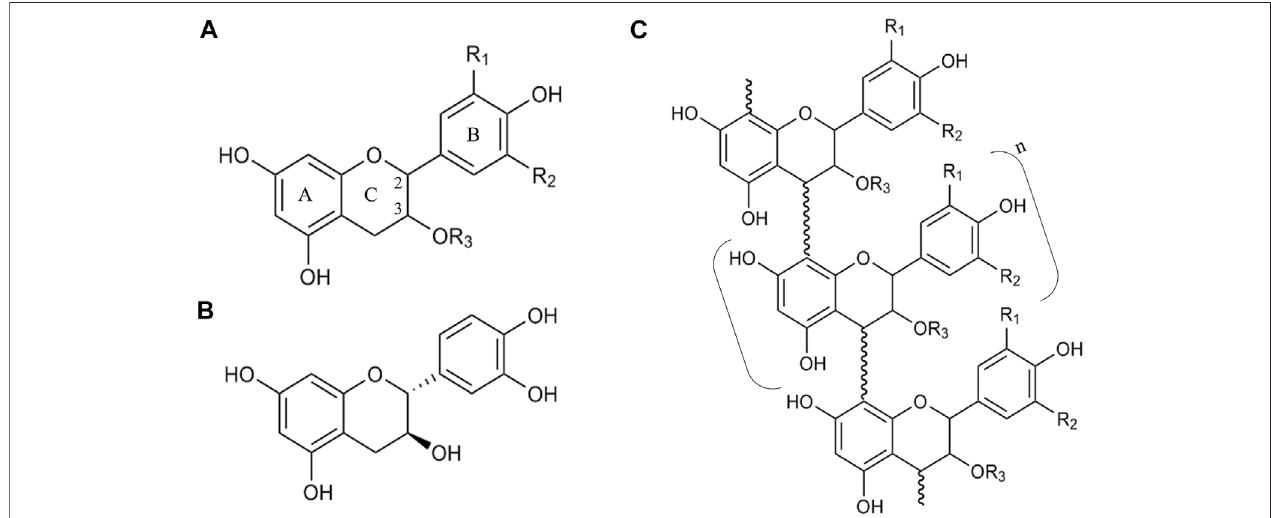
FIGURE 2 | Schematic of the structure of catechins and proanthocyanidins. (A) General structure of a catechin, where (A – C) indicate the distinct rings of the carbon backbone C6-C3-C6, numbers 2 and 3 indicate the chiral carbons (stereochemistry not shown), and R 1 , R 2 and R 3 are the possible substituent groups. (B) An example of a catechin (+)-catechin. (C) General structure of a proanthocyanidin, where n indicates the number of repetitions of the monomer in brackets. The bond between the monomers is called an inter fl avan